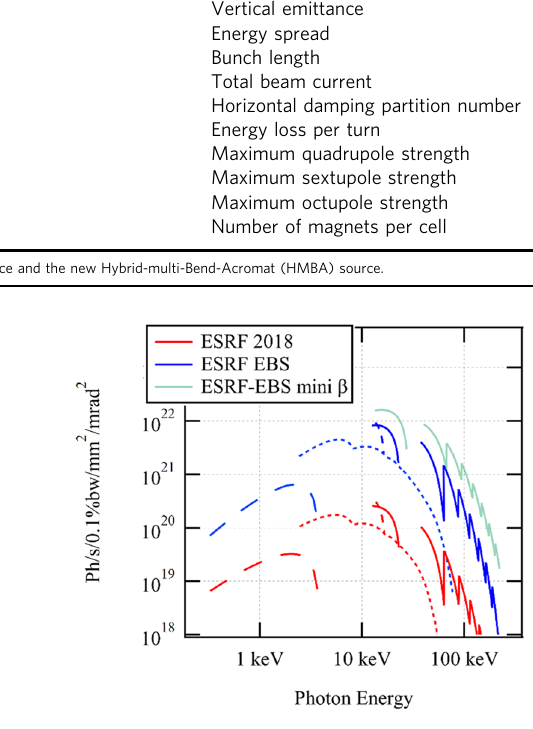
Fig. 2 Brilliance curves. The fi gure shows the brilliance curves for the former ESRF lattice (red), for the EBS lattice (blue) and for a future EBS upgrade with “ mini- β ” sections and ultra-short-period undulators (green). The dashed curves are for ex-vacuum undulators: 88 mm period, 4 m long circular polarisation undulator at low-energy, 35 mm period, 4.8 m long planar undulator at medium energy, and 20 mm period, 4.8 m long planar undulator at 14 keV. The solid curves are for 2 m long cryogenic permanent magnet undulators (CPMUs) with 14.4 mm period for the ESRF DBA and ESRF EBS, and 12 mm (still to be built and demonstrated) for future mini- β upgrades. The brilliance curves were computed with the SRW software 125 , taking into account the energy spread and detuning 126,127